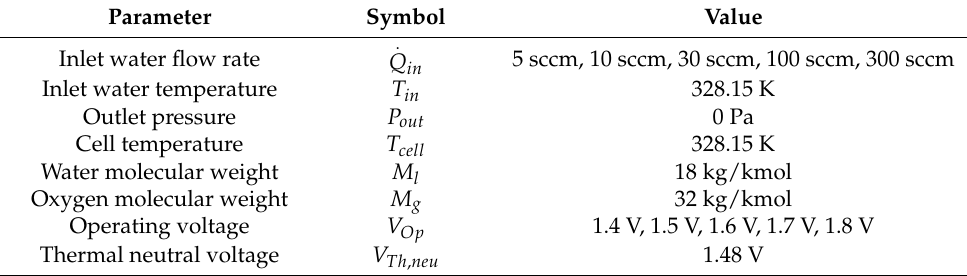
Table 5. Parameters used in the boundary conditions of the PEMWE model. Parameter